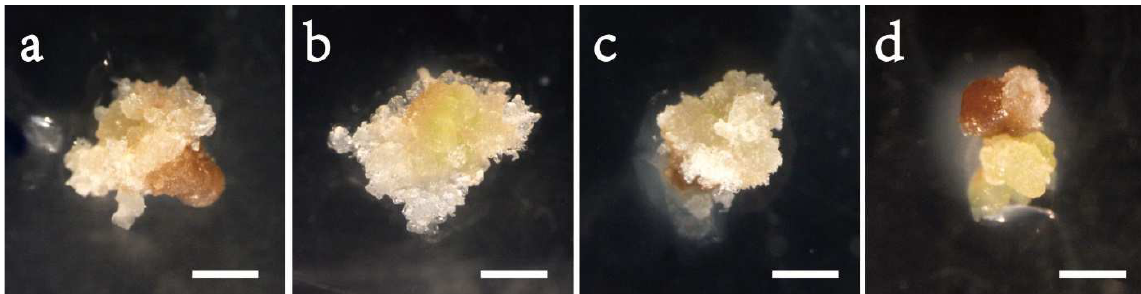
Figure 1. Initiation of embryogenic cell mass of the provenance F1 in Picea pungens SE under various 2,4-D concentrations: ( a ) 0 mg/L; ( b ) 2 mg/L; ( c ) 4 mg/L; and ( d ) 6 mg/L. Bars: ( a – d ) = 1 cm.